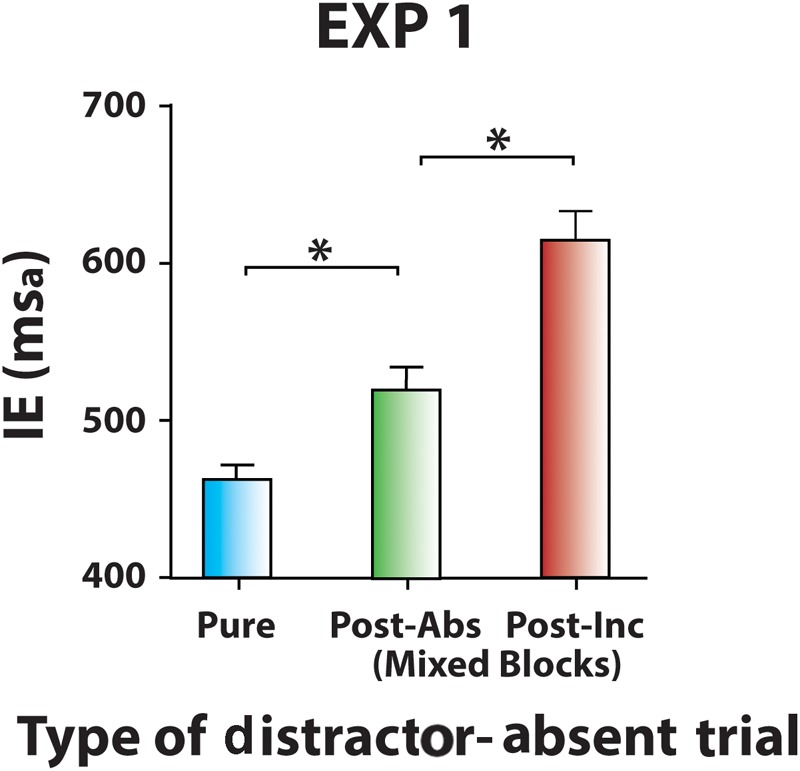
Sequential effects on distractor-absent trials (Experiment 1). Mean IEs on distractor-absent trials in Pure block, in Mixed blocks following distractor-absent trials and in Mixed blocks following incongruent distractor trials. Data of Mixed blocks come from collapsing 60% Cong block and 60% Inc block data. Error bars represent the standard error. Asterisks mark significantly different mean/s.